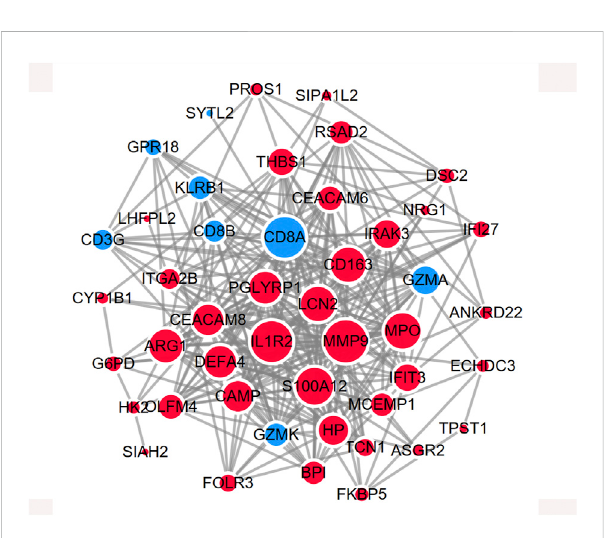
FIGURE 5 PPI network showing the protein interaction for shared DEGs between MDD and IS. The red color represents the commonly upregulated genes. The blue color represents the common downregulated genes. The size ofthecircle indicatesthe Degree of the node. The PPI network was generated using STRING and visualized in Cytoscape.